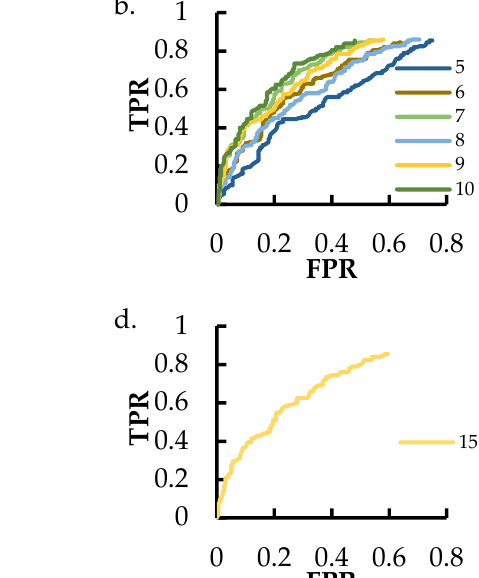
Figure 8. Extraction results of quadrat 2 combination at different phenological stages. ( a ) Single phenophase; ( b ) Combined time series of dual phenology; ( c ) Combined time series of triple phe- nology; ( d ) Full phenological stage with 1–15 corresponding to the combination numbers of differ- ent phenological stages in Table 4.